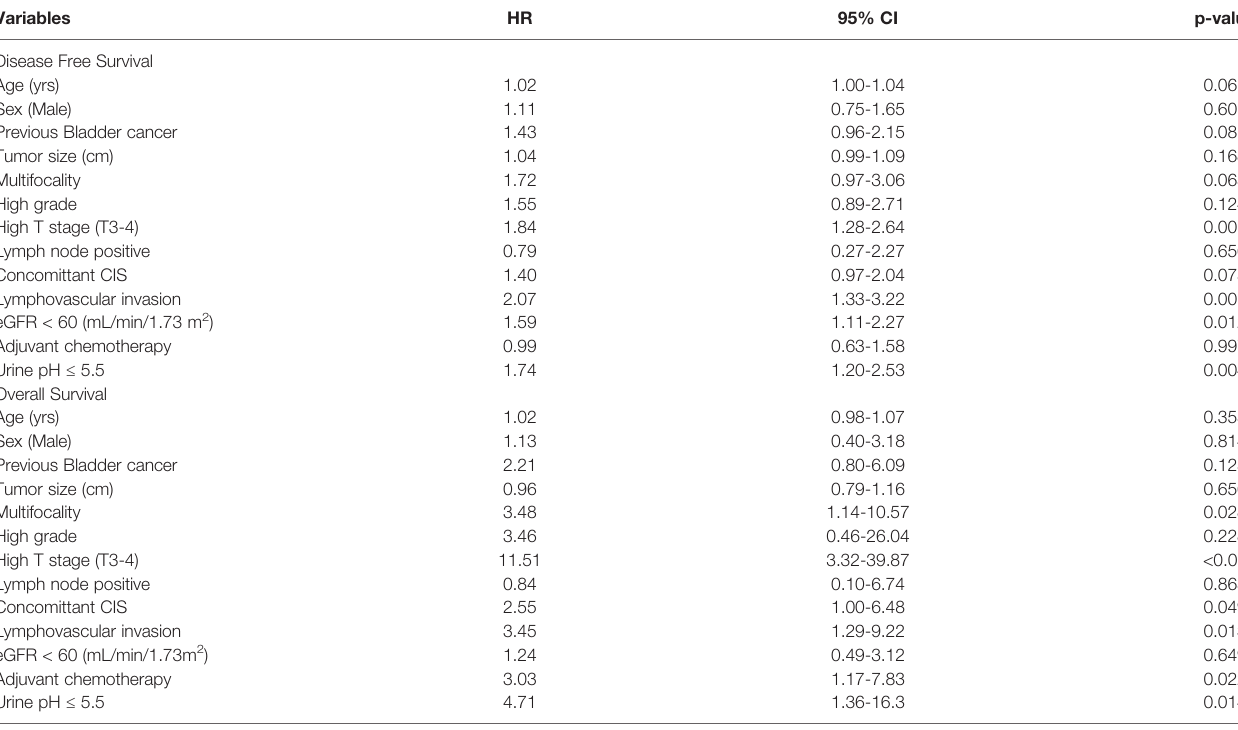
TABLE 4 | Univariate Cox regression analysis of disease-free survival and overall survival. Variables HR 95% CI p-value Disease Free Survival Age (yrs)